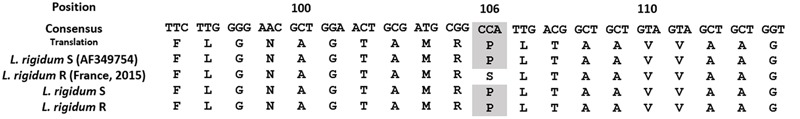
Partial gene sequence alignment of the EPSP synthase of resistant (R) and susceptible (S) rigid ryegrass biotypes.